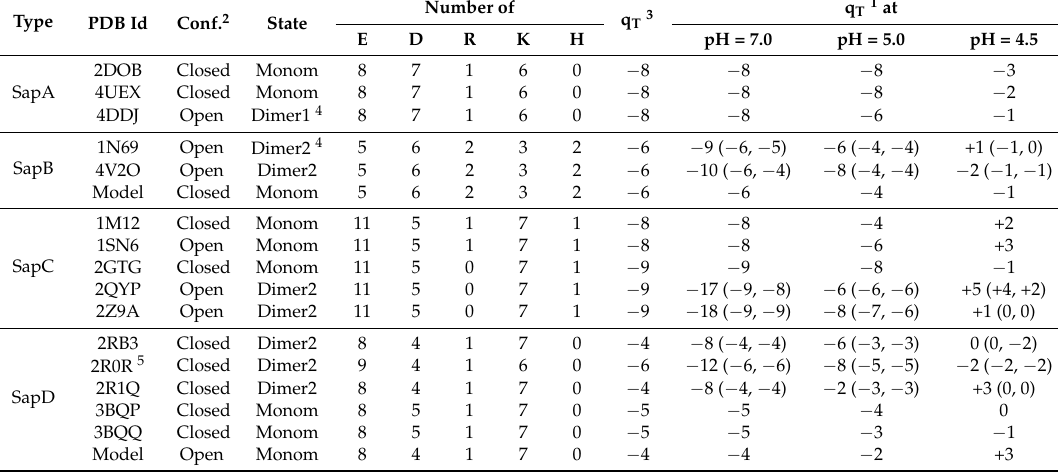
Table 3. Acidic and basic amino acids and total charge q T of human saposins at different pH values.